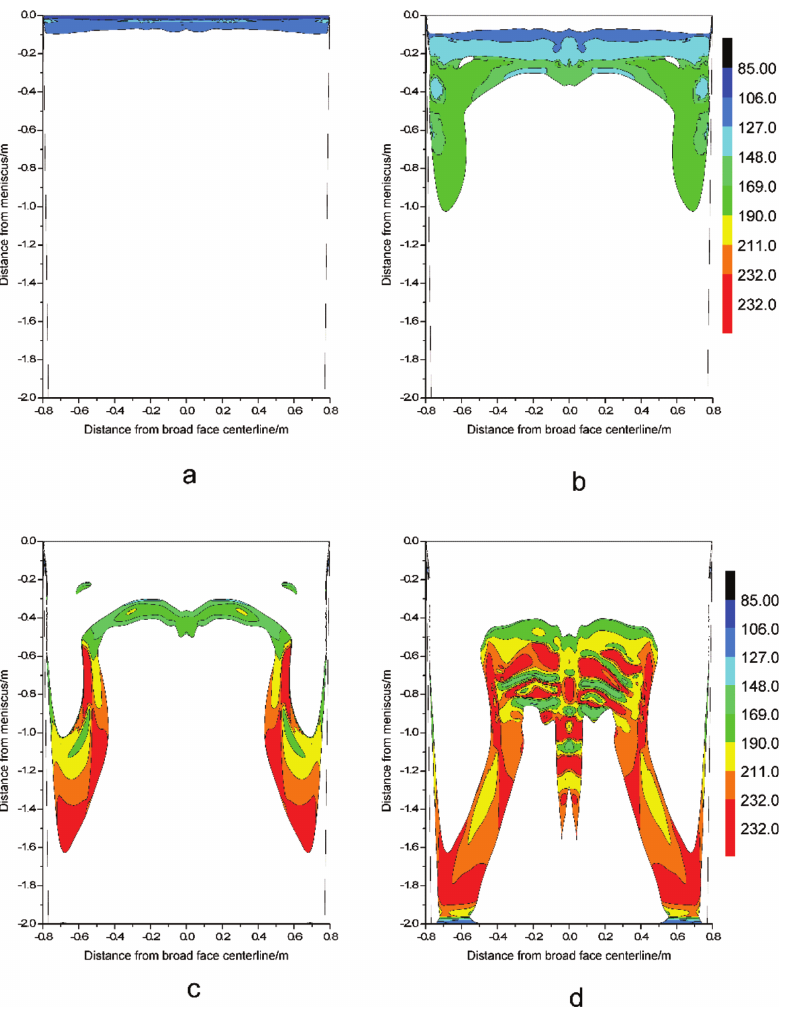
Figure 11: PDAS of the inclusion capturing area at different depths: 0~0.01m from broad surface (a) 0.01~0.02m from broad surface (b) 0.02~0.03m from broad surface, (c) 0.03~0.04m from the slab surface